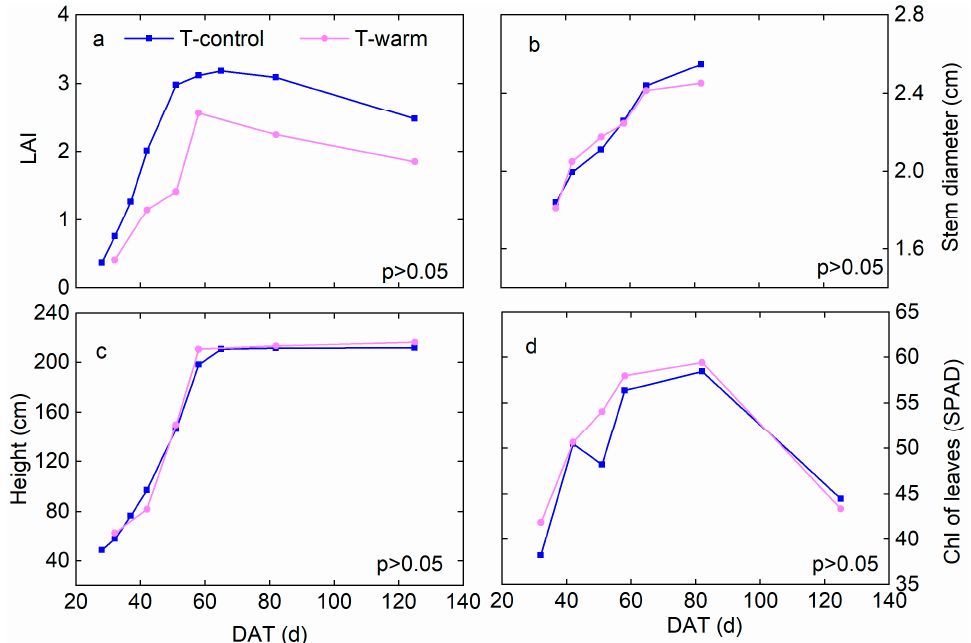
Figure 7. Temporal variations in ( a ) leaf area index (LAI), ( b ) stem diameter, ( c ) height and ( d ) Soil and Plant Analyzer Development (SPAD) value of maize in T-control and T-warm experiments.